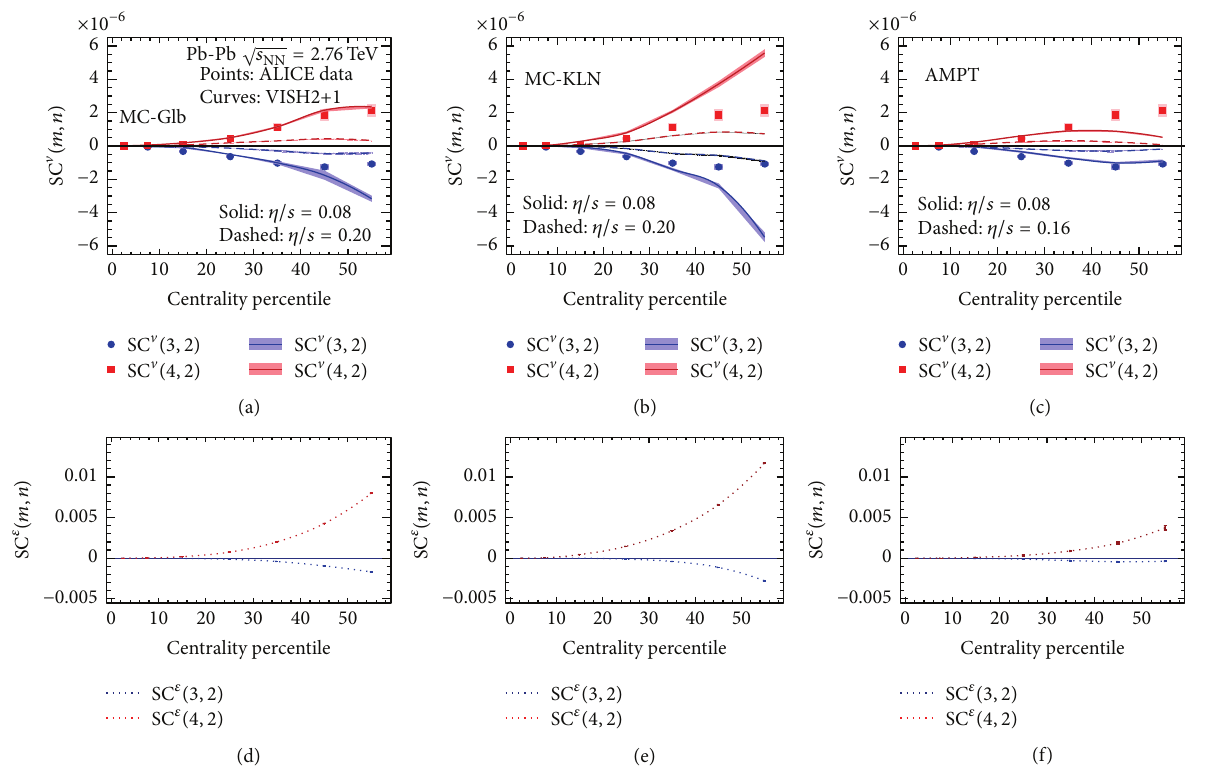
Figure 7: The centrality dependence of symmetric cumulants SC (4,2) (red markers) and SC (3,2) (blue markers) at √𝑠 NN = 2.76 TeV Pb–Pb collisions by VISH2+1 simulations. Figures are taken from